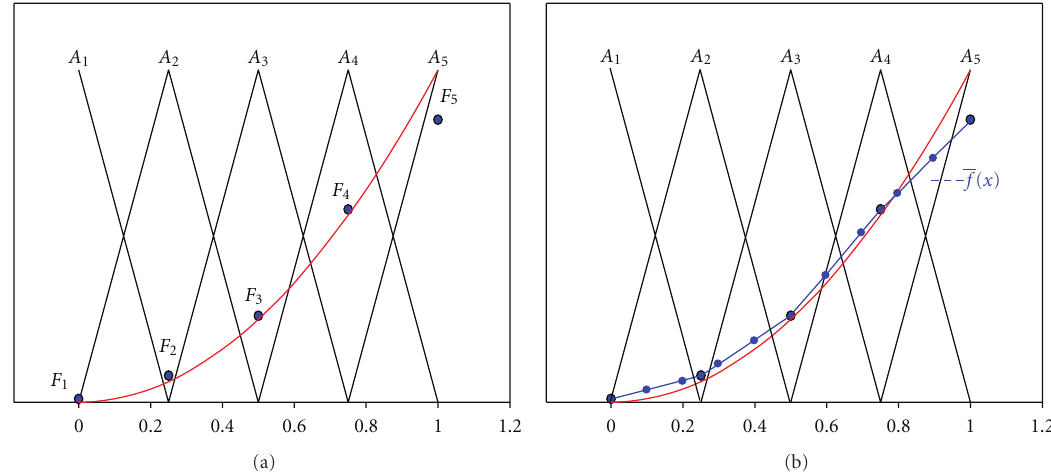
Figure 1: Function x 2 on [0,1] and its F-transform components F 1 , ... , F 5 with respect to A 1 , ... , A 5 (a). Function x 2 on [0,1] and its inverse F-transform f